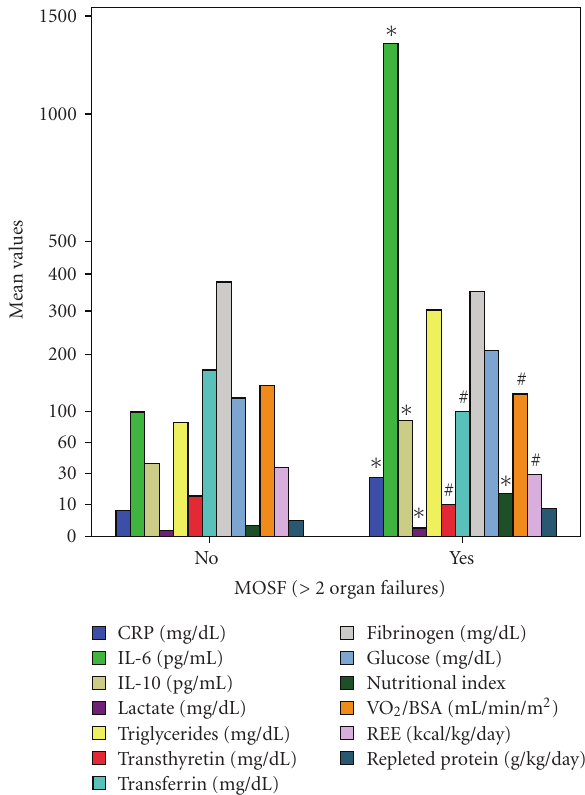
Figure 3: Comparison of metabolic monitor measurements, vari- ous cytokines, and nutritional markers between patients with and without multiple organ system failure (MOSF) (scale type power: exponent 0.5). Significantly increased ( ∗ ) in the presence of MOSF: C-Reactive Protein (CRP), Interleukin-6 (IL-6), Interleukin-10 (IL-10), nutritional index, and lactate ( t -test for unpaired data). Significantly decreased (#) despite a higher protein intake: Oxygen Consumption (VO 2 ), Resting Energy Expenditure (REE), transfer- rin and transthyretin. Did not di ff er compared to the non-MOSF patients: triglycerides, glucose, fibrinogen. BSA: Body Surface Area.